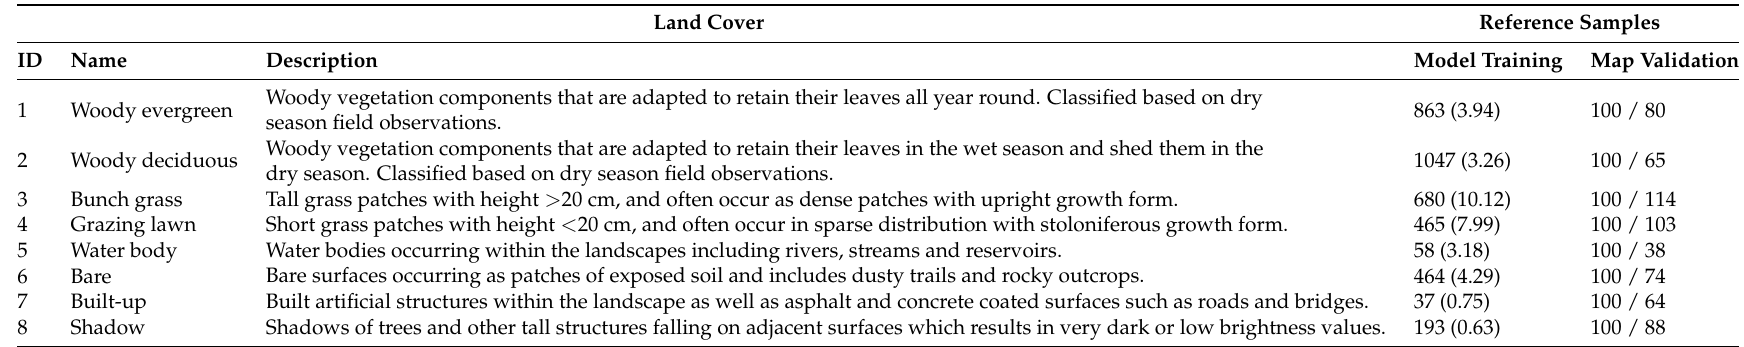
Table 1. Description of land cover classification nomenclature and reference data. Numbers represent number of reference points, while figures in parenthesis represent area of training polygons in hectares. Lower Sabie and Satara validation points are separated by “/” (i.e., Lower Sabie/Satara).